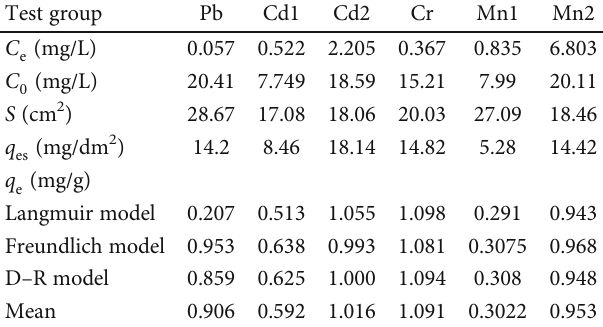
Table 3: Adsorption capacity of equivalent mass